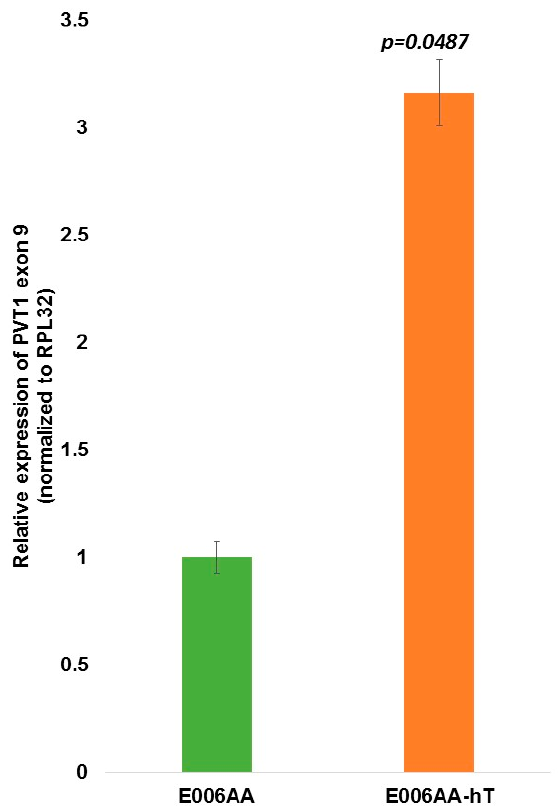
Figure 7. PVT1 exon 9 expression in non-tumorigenic and tumorigenic prostate epithelial cell lines. At least three independent qPCR experiments were performed and every experiment was set up in quadruplicates. The data showed that PVT1 exon 9 is consistently significantly overexpressed in the aggressive PCA cell lines derived from MoAA. The data are presented as mean + standard error of the mean (SEM) and the p values are displayed on the figure, and are compared to the control (RWPE1 cell